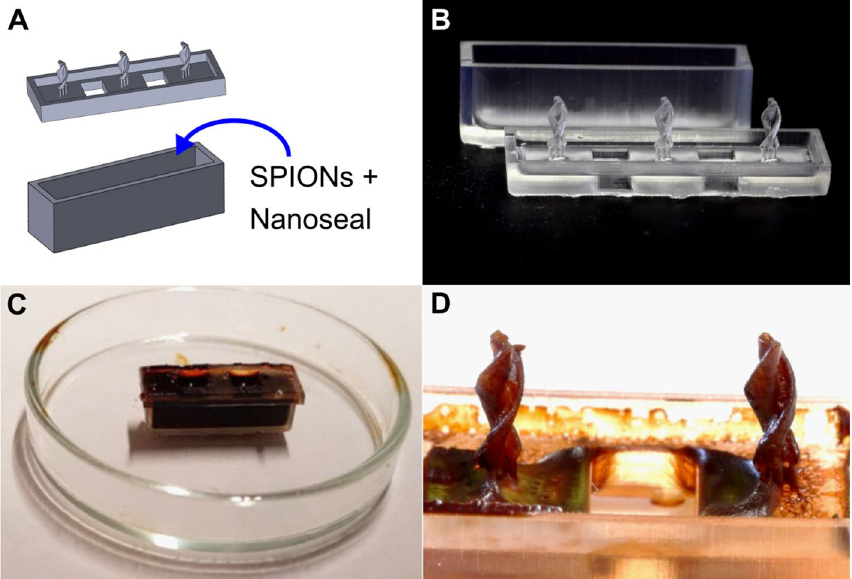
Figure 7. Coating procedure of the micro-robot. ( A ) CAD model of three micro-robots attached to a cap of a little basin. ( B ) 3D-printing of the micro-robots and the basin. ( C ) The tank was then filled with the SPION- impregnating agent suspension. The tank was closed with the cap, such that the micro-robots are dipped into the suspension. ( D ) The evaporation of the water in the suspension formed the SPION coating of the micro- robot. Afterwards the swimmers are being detached from the cap and the tip is painted with a NdFeB containing lacquer, as can be seen in Fig.